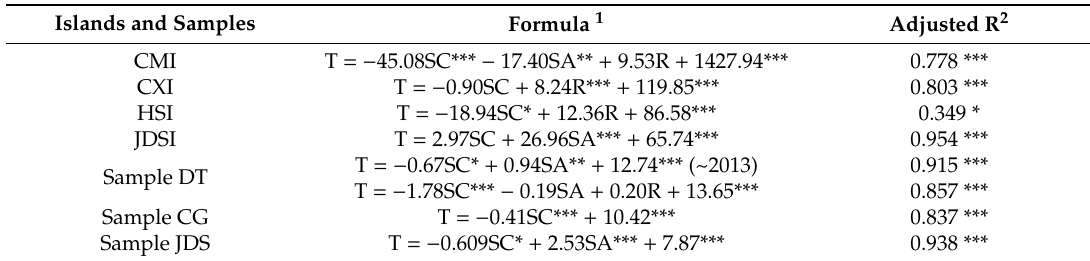
Table 4. Statistical summary of the multiple linear regression formula in four islands and two samples. Islands and